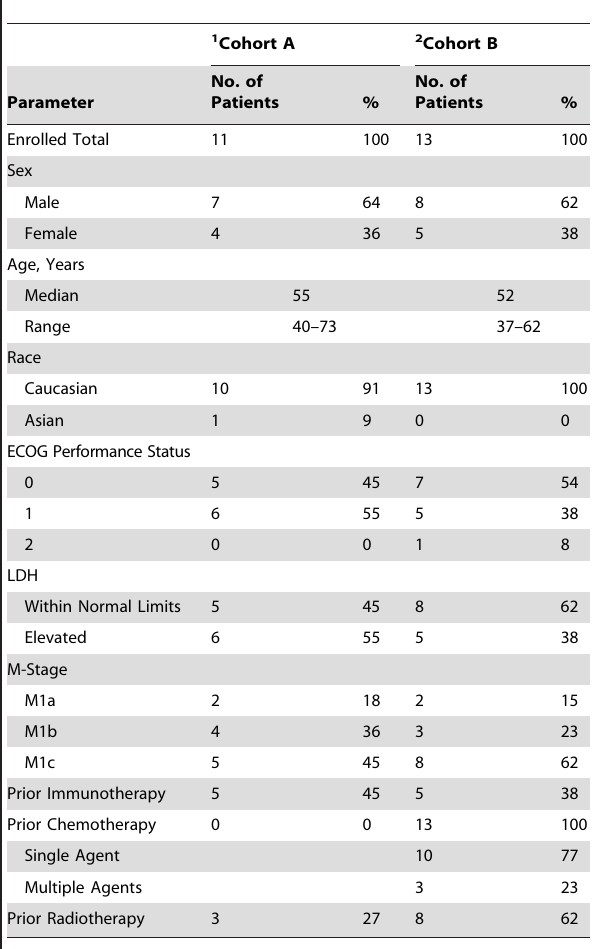
Table 1. Patient demographics and disease characteristics.